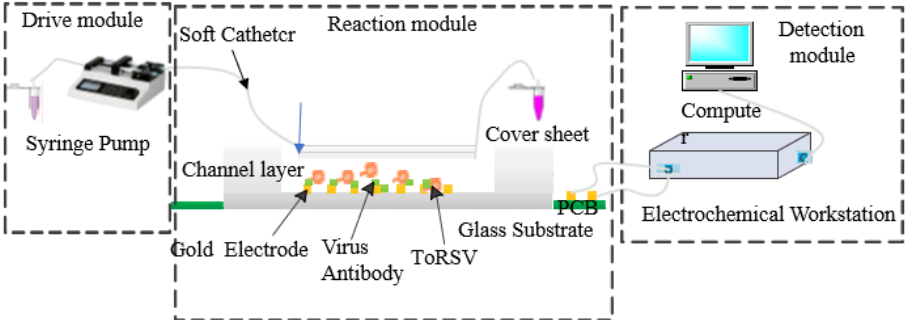
Figure 3. Schematic diagram of the microfluidic impedance detection system.